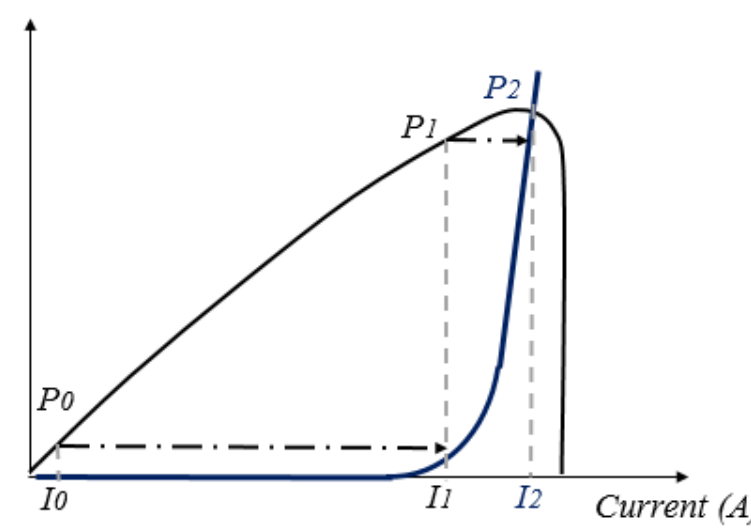
Figure 9. PEMFC PI characteristics and tracking trajectory.